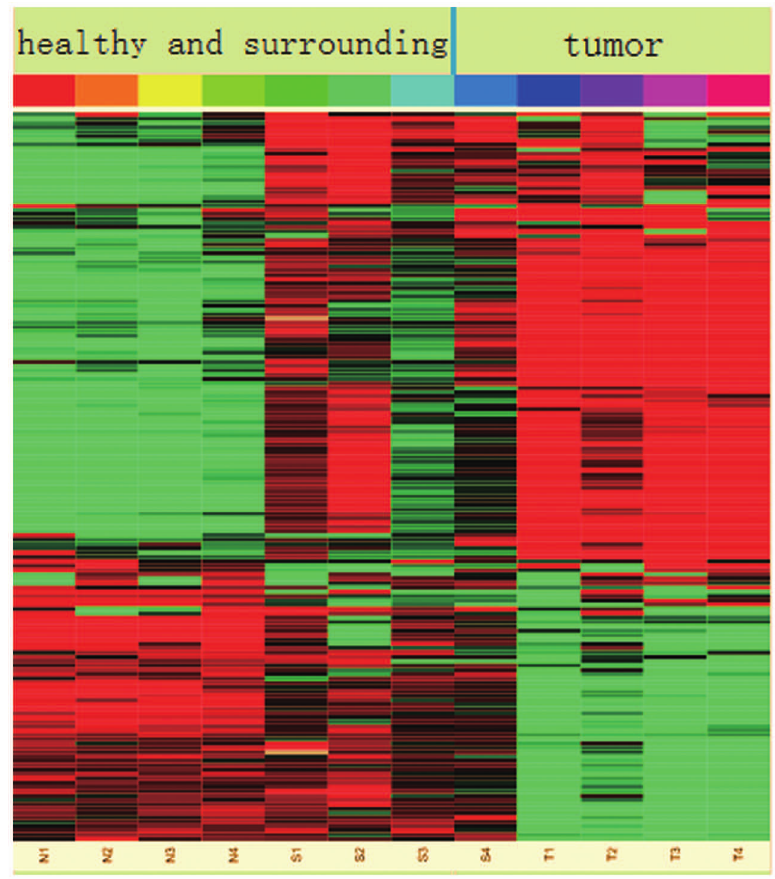
Figure 4. Unsupervised gene cluster of 168 genes. The heat map of these genes shows different methylation between tumor tissues and normal tissues. Red indicates hypermethylation, while green indicates